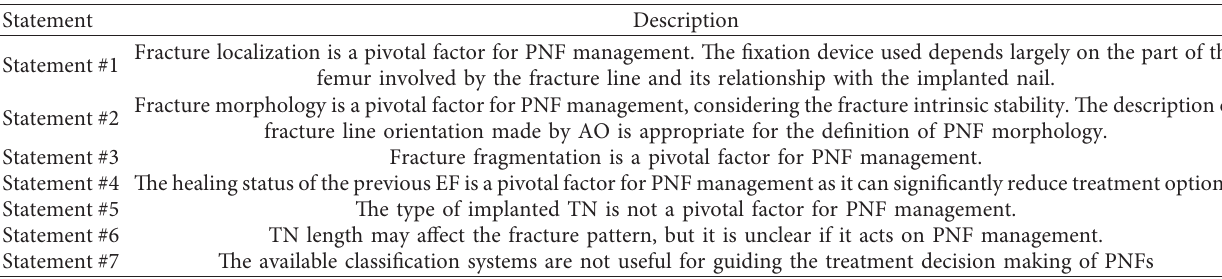
Table 2: Statements on the management of